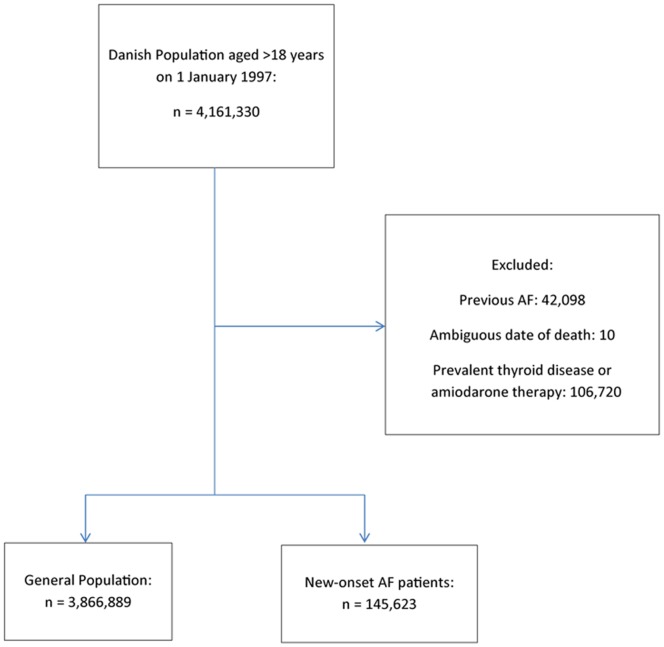
Flowchart of study cohort selection. AF, Atrial Fibrillation.